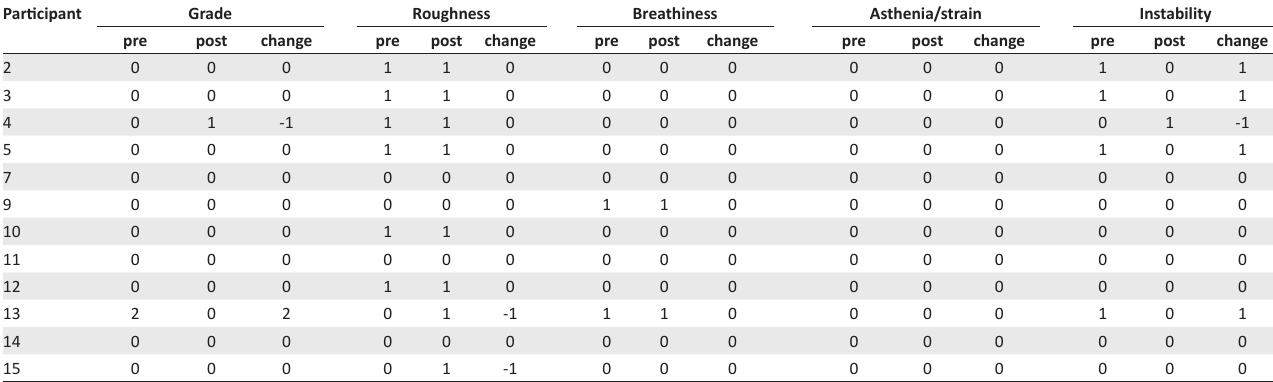
TABLE 4: Perceptual analysis results: Change in scores from pre- to post-test. Participant